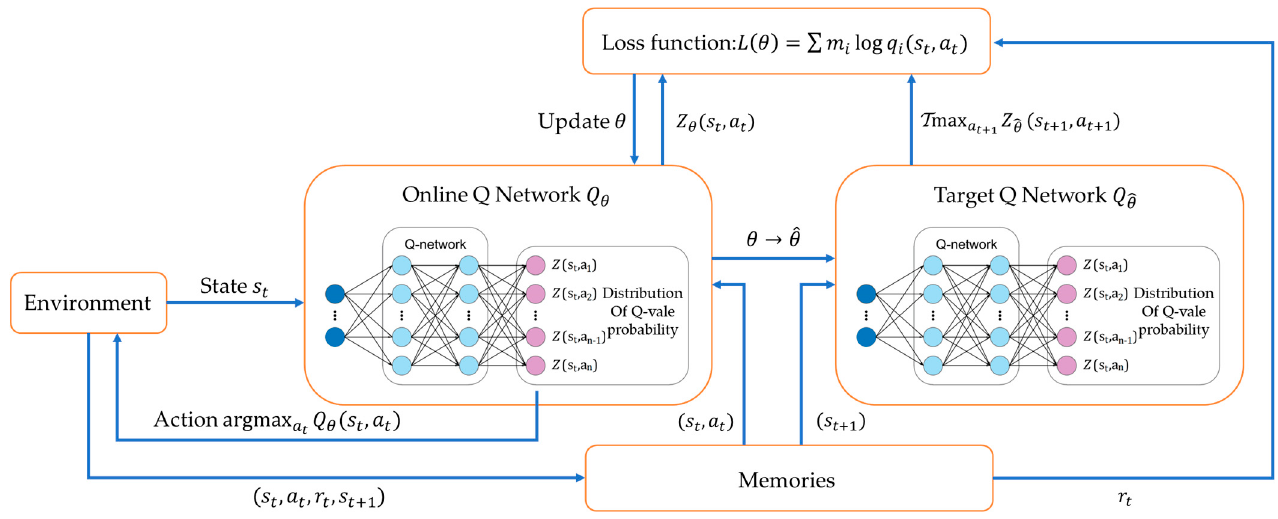
Figure 6. Framework of the distributional DQN algorithm.